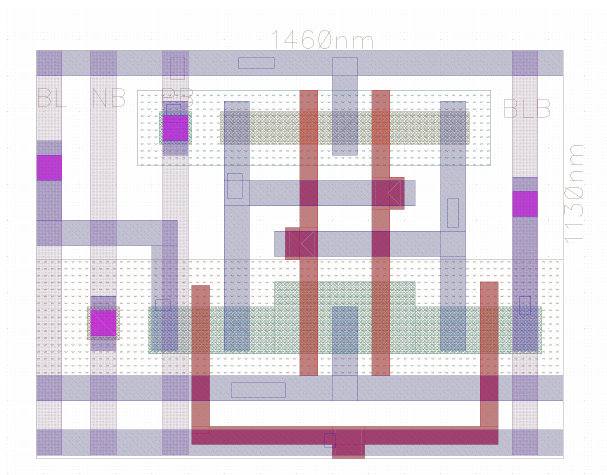
Figure 3. 6T SRAM cell layout with separate body terminals.